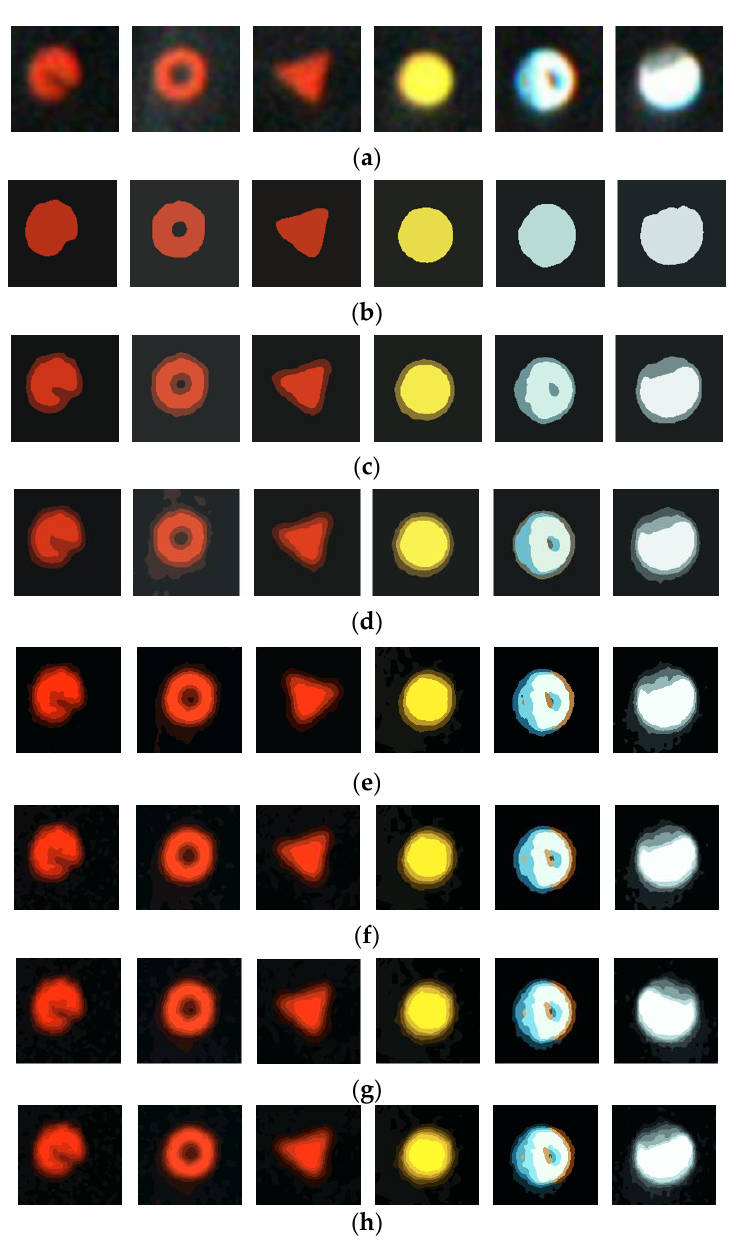
Figure 6. The results of the K-means clustering segmentation algorithm: ( a ) Original image of marking points, ( b ) The segmented images by clustering when k = 2, ( c ) The segmented images by clustering when k = 3, and ( d ) The segmented images by clustering when k = 4, ( e ) The segmented images by clustering when k = 5, ( f ) The segmented images by clustering when k = 6, ( g ) The segmented images by clustering when k = 7, ( h ) The segmented images by clustering when k = 8. The marking point samples with the same color and shape (for example red and circle) are selected, which can be regarded as a whole image. The K-means clustering methods with the di ff erent k values are used to segment this image. N i is the number of pixels in a region i ( i = 1, 2, . . . , k ), T is the total pixels of the whole image. P i is indicated by the percentage of N i to T , which can be calculated. For K-means clustering with k = 3 and k = 4, the area with a large value of the luminance channel (V channel) of the Hue-Saturation-Value (HSV) space is divided into several regions, and the area with a small value of the V channel is a whole region, which can be regarded as the background. For example, when k = 4, P 1 = 0.08, P 2 = 0.10, P 3 = 0.08, and P 4 = 0.74, their corresponding values